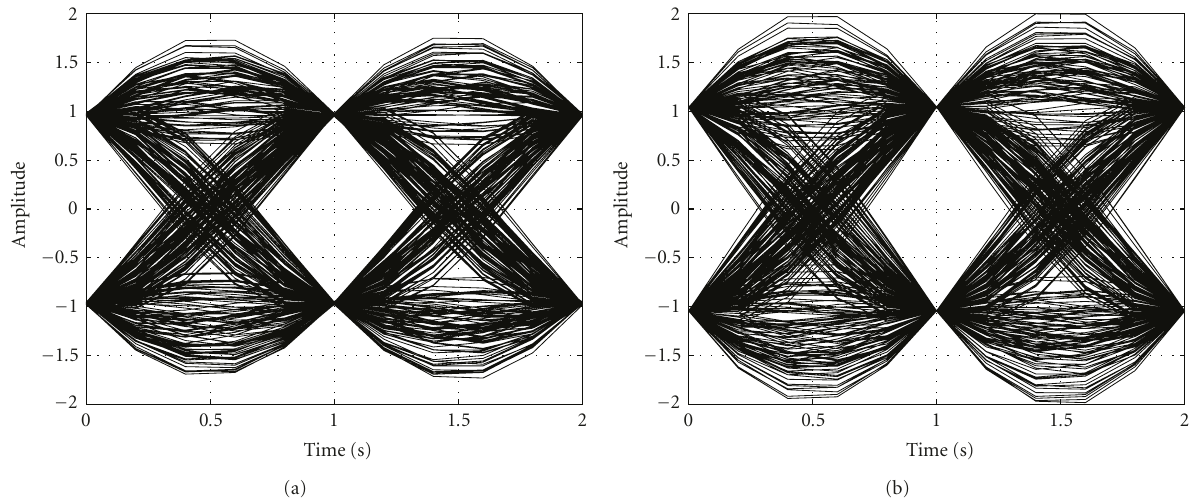
Figure 11: Eye diagrams of the transmitter and receiver cascade (a) RC filter; (b) Nyquist δ -filter, α = 0 . 284; G D = 12; N = 5; N O = 120.